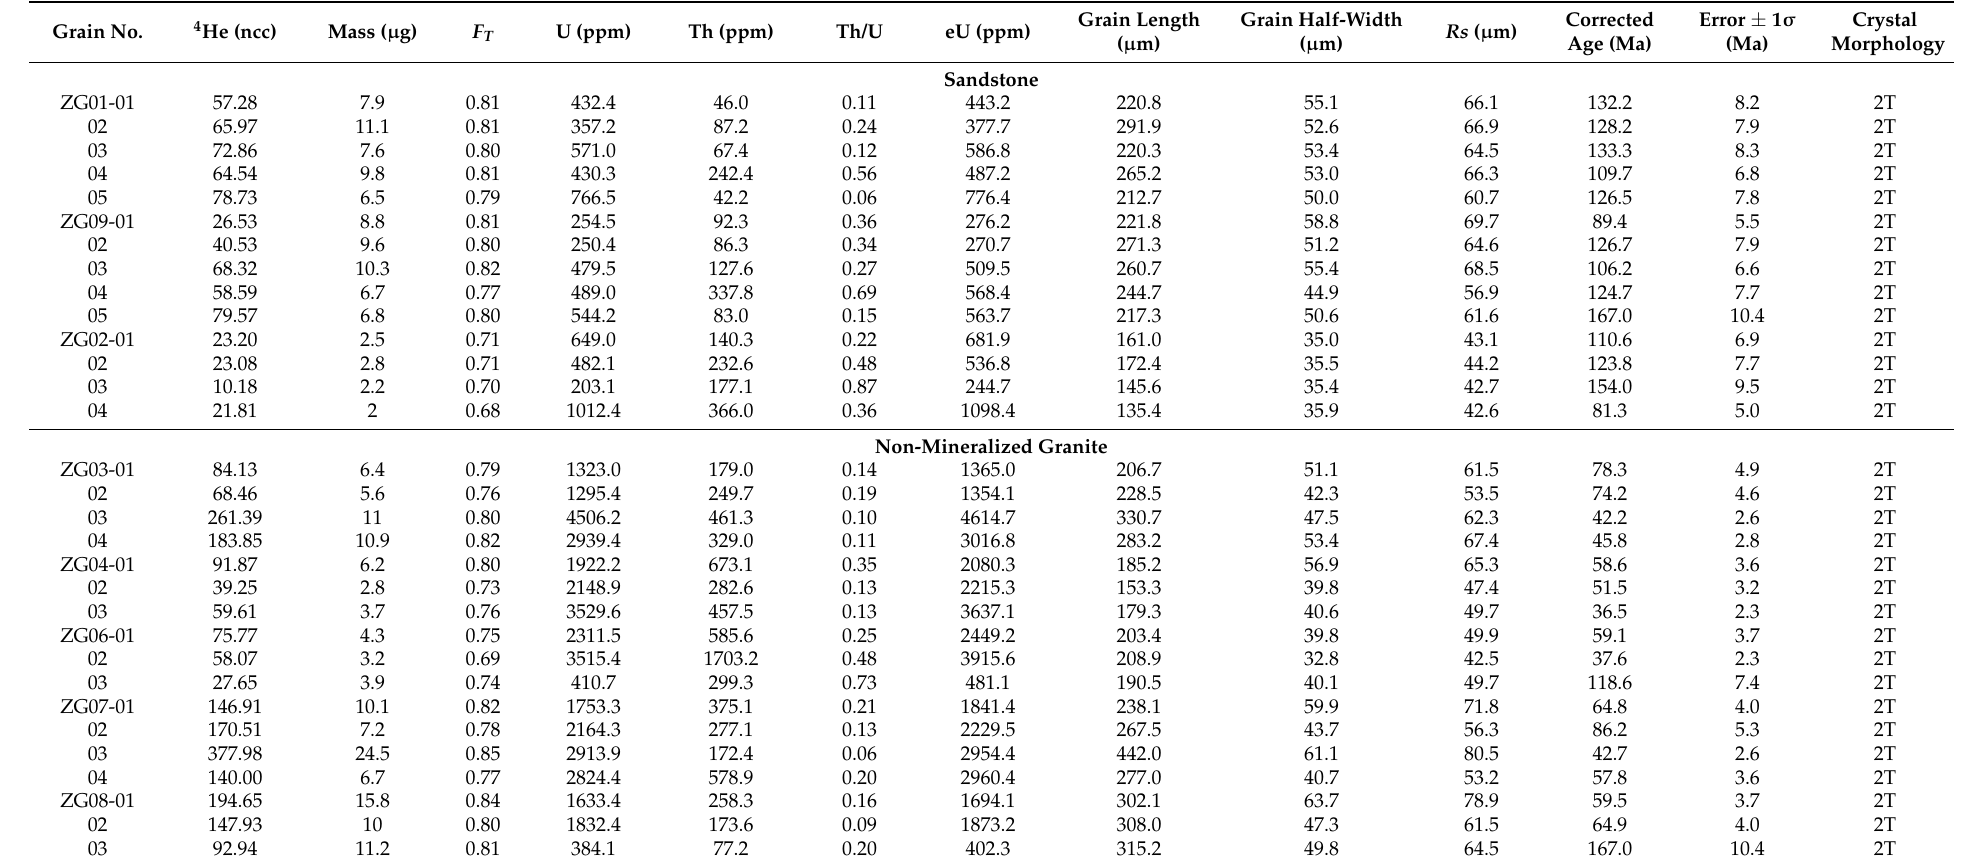
Table 2. Zircon (U-Th)/He data from the Lujing uranium ore field region, South China.